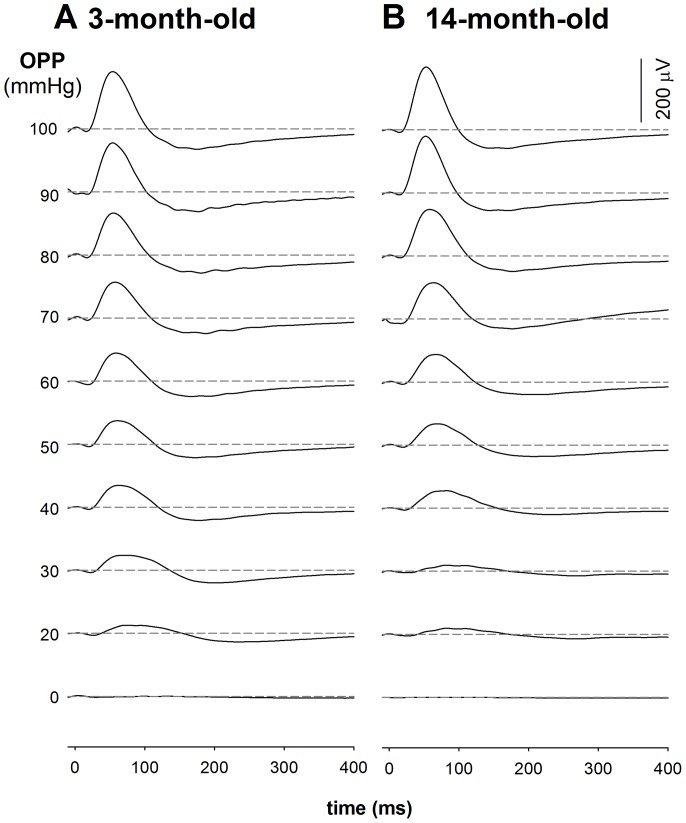
Representative photopic ERG waveforms alter with IOP induced OPP changes in 3-month-old (A) and 14-month-old (B) rats.ERGs were collected after 15 min of light adaptation on a 15/m2 background in young (n = 14) and old (n = 16) Long Evans. Panel A shows a typical gradient OPP profile for the ERG in a 3-month-old rat with a baseline blood pressure of 116 mmHg. Panel B shows a typical gradient OPP profile for the ERG in a 14-month-old rat with a baseline blood pressure of 114 mmHg.